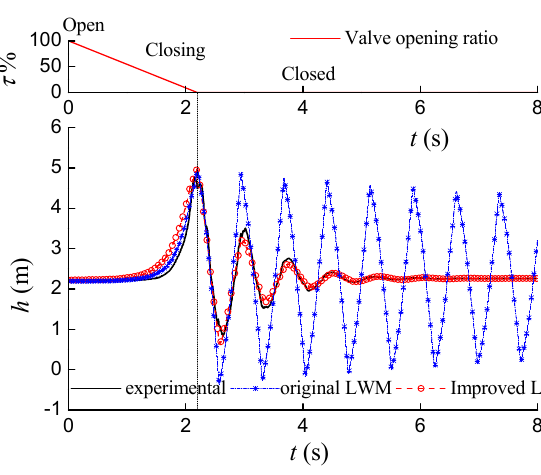
Figure 11. Simulation by improved two-phase model.